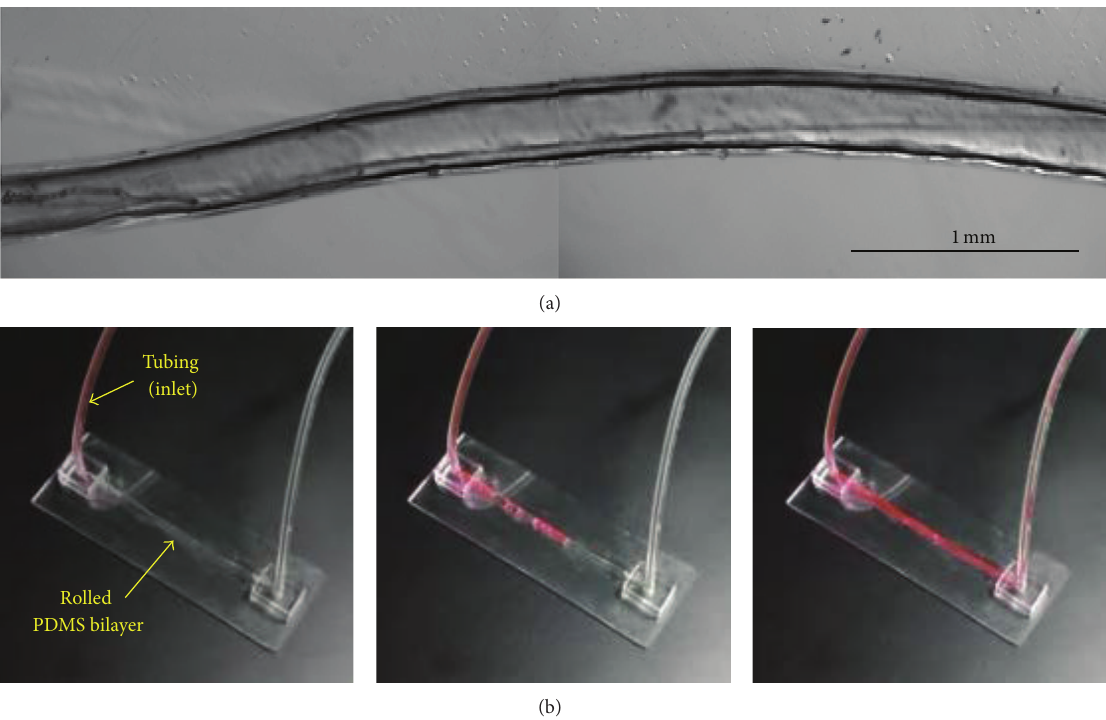
Figure 4: An optical micrograph of the centimeter-long rolled PDMS bilayer (a), which was connected to inlet and outlet tubing using small pieces of PDMS block to form a microchannel on the glass substrate (b). The aqueous solution containing rhodamine B dye was perfused into the microchannel at a volumetric flow rate of roughly